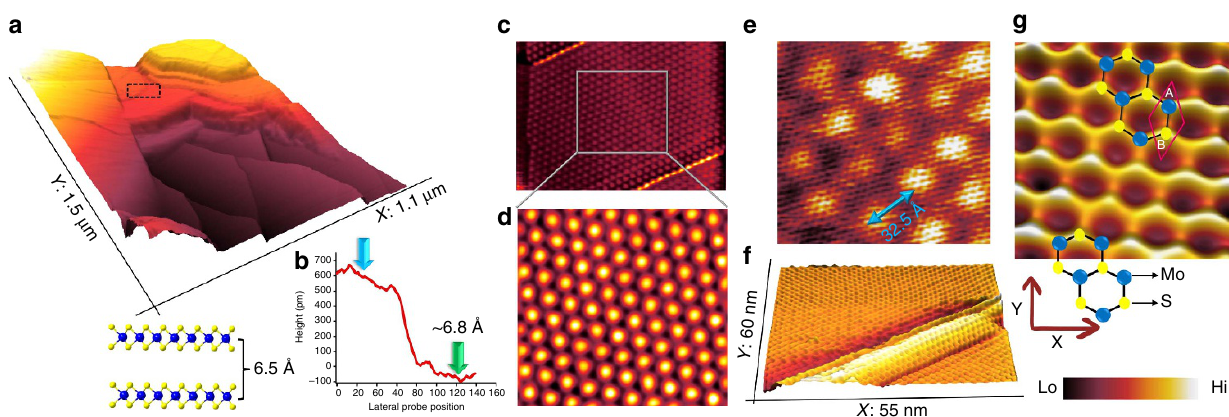
Figure 6 | Imaging the atomic lattice of 2D MoS 2 on Au(111) in liquid using a molecular STM probe. ( a ) Large-area STM image of MoS 2 grown on Au(111), imaged using a C 60 -terminated Au probe in silicone liquid environment ( I t ¼ 650pA, V b ¼ 1.1V). A line section analysis at the MoS 2 –Au interface shows a height difference of B 6.8Å ( b ) indicating a region of single layer MoS 2 . The probe is then positioned on the region marked by the black rectangle in a and a higher-resolution constant current image is obtained ( c ) which shows the atomic structure of MoS 2 and the bare Au surface at the